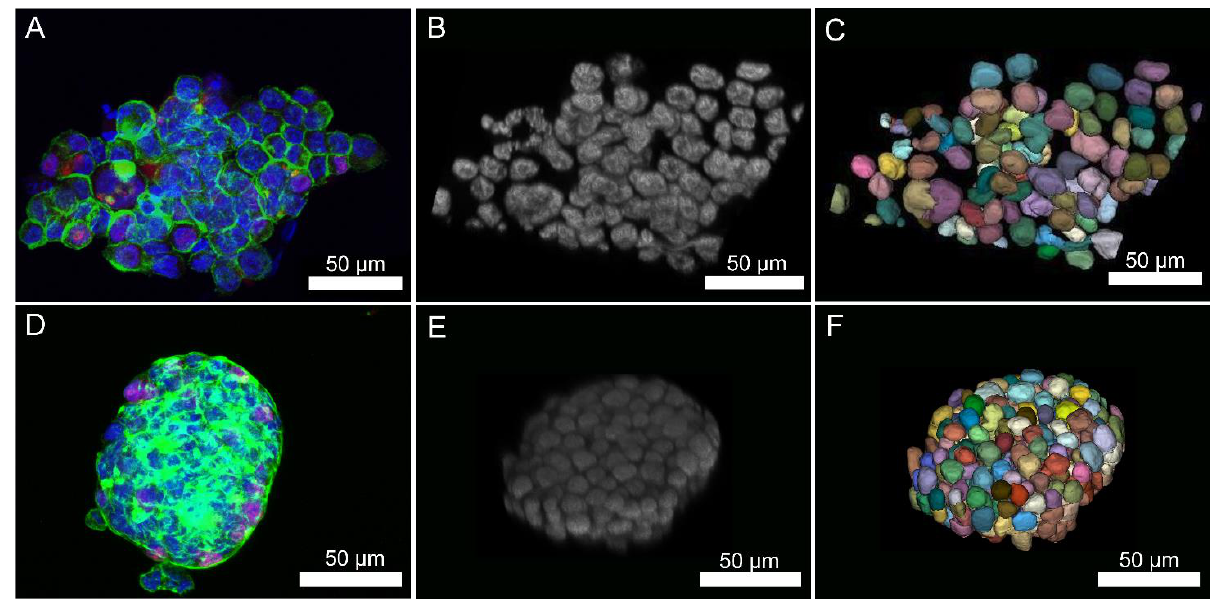
Figure 6. ( A ) PC3 cell spheroid cultured in 1.0% nanofibrillated cellulose (NFC) hydrogel for 7 days. Nuclei were stained with DAPI (blue), Ki67 proliferation marker with Alexa Fluor 594 (red), and actin cytoskeleton with Phalloidin conjugated Alexa Fluor 488 (green). ( B ) A grayscale figure of nuclei of PC3 spheroid for automatic segmentation. ( C ) Automatically segmented nuclei of the multicellular 3D PC3 cell spheroid. ( D ) HepG2 cell spheroid cultured in 0.8% NFC hydrogel for 7 days. Nuclei were stained with DAPI (blue), Ki67 proliferation marker with Alexa Fluor 594 (red), and actin cytoskeleton with Phalloidin conjugated Alexa Fluor 488 (green). ( E ) A grayscale figure of nuclei of HepG2 cell spheroid for automatic segmentation. ( F ) Automatically segmented nuclei of the multicellular 3D HepG2 cell spheroid.